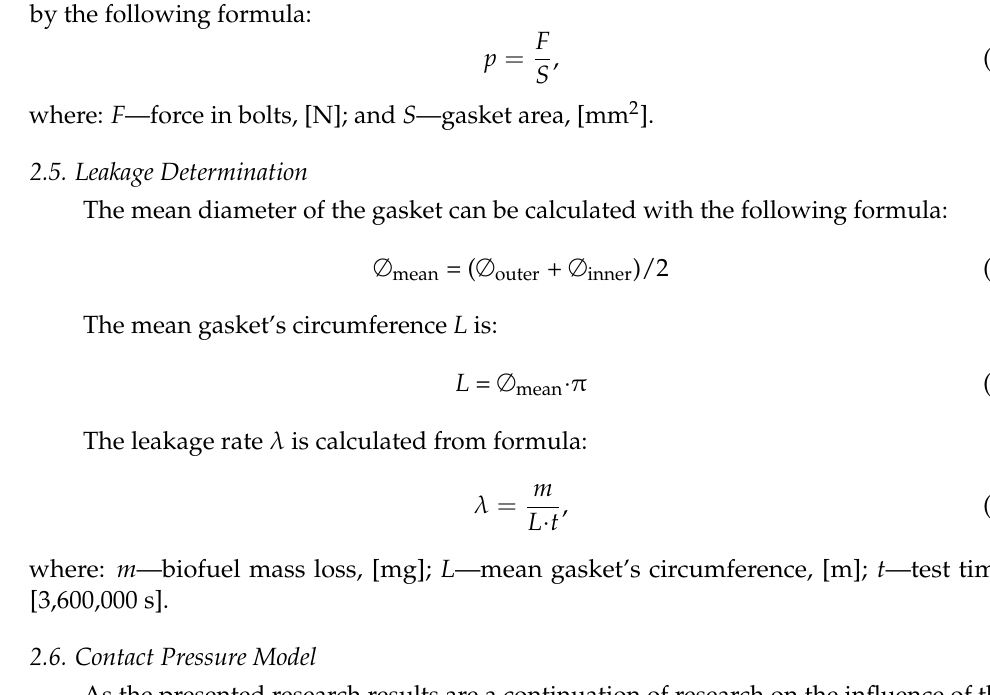
Figure 3. Research stages: ( a ) gasket assembly, ( b ) tension control of bolts, ( c ) weight control. The bolts used in the tests were calibrated. In order to elongate the bolts, they were tightened. The determined constant of the bolt elongation was 0.443 kN/µm. By knowing the bolt elongation, it is possible to determine the force F . Contact pressure p is described